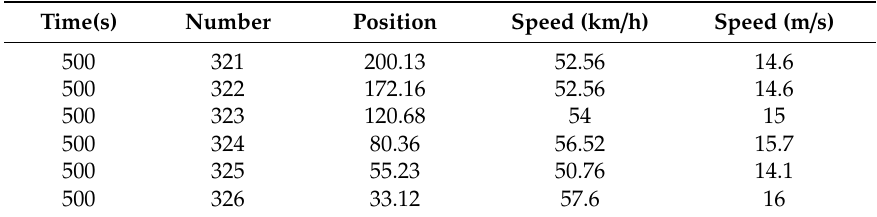
Table 1. Initial speed information on lane